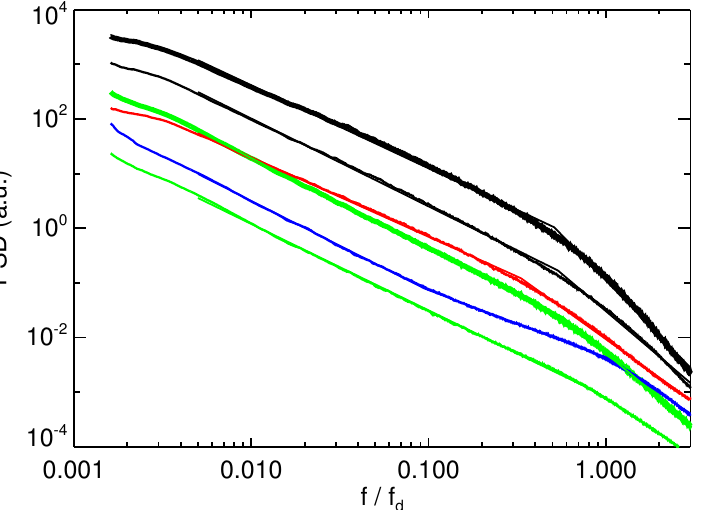
Figure 6. Median spectra of V ⊥ (thick black), V (cid:107) (thin black), B ⊥ (thick green), B (cid:107) (thin green), N (blue) and V th (red) fluctuations. The straight thin lines of corresponding colors show the fits (note that they are distinguishable only around the spectral break). The slopes of linear fits in both inertial and kinetic ranges are given in the last row of Table